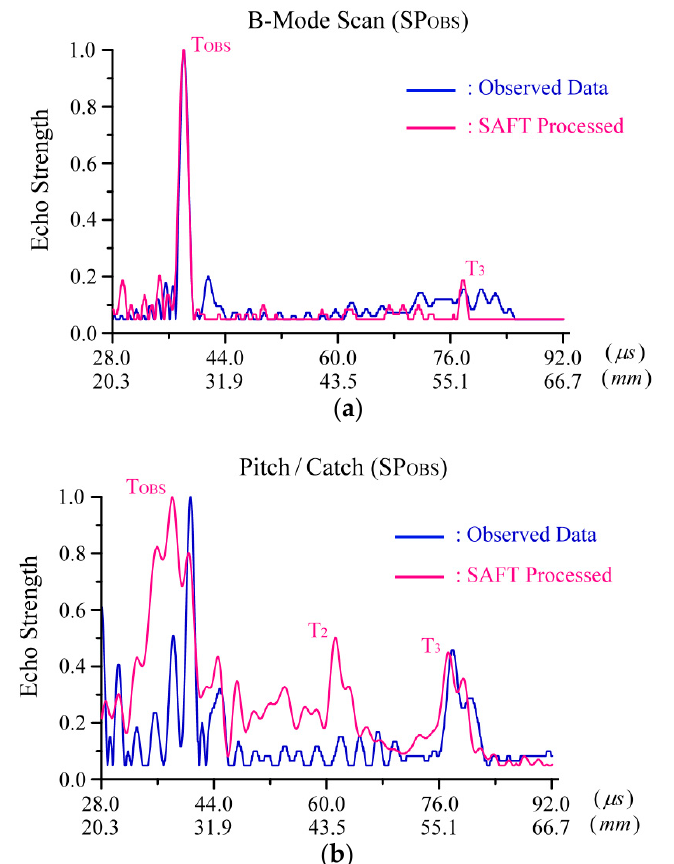
Figure 6. Echo strength analyses of ( a ) B-mode scan and ( b ) pitch/catch scan at SP OBS . Through the processed noise with restoration, the resolutions of imaged targets are enhanced. Table 1. Details of the original observations (raw data) and SAFT-processed data for the B-mode scan (Figure 3). Numbers shown below the targets (T OBS and T N ) are the depths of the centers and the tops of the relative holes (center/top). Numbers above the slash of relative imaged echoes show the information of original observations and those below the slash are obtained from the results of the SAFT process.